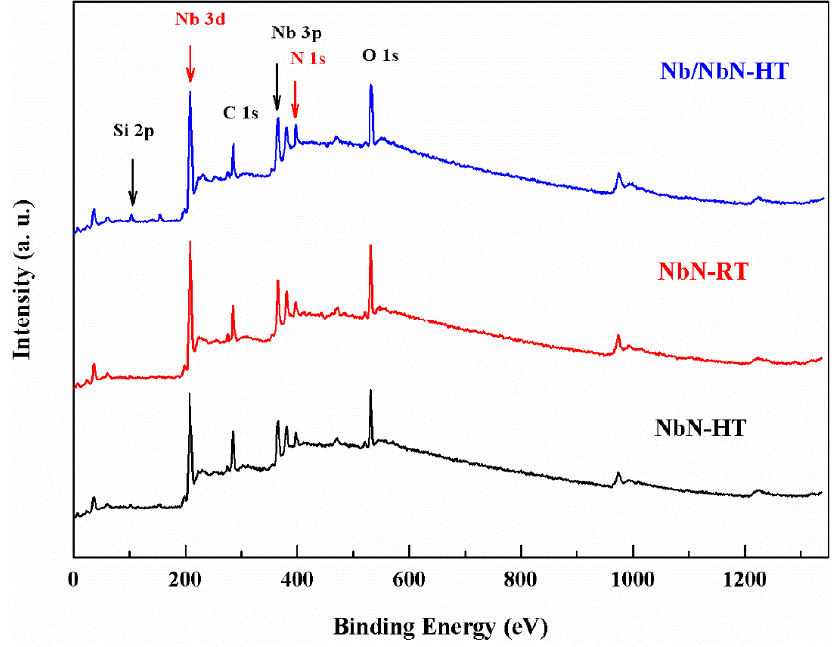
Figure 4. XRD pattern of Nb/NbN-HT coating deposited on 304 SS substrate at a high temperature.